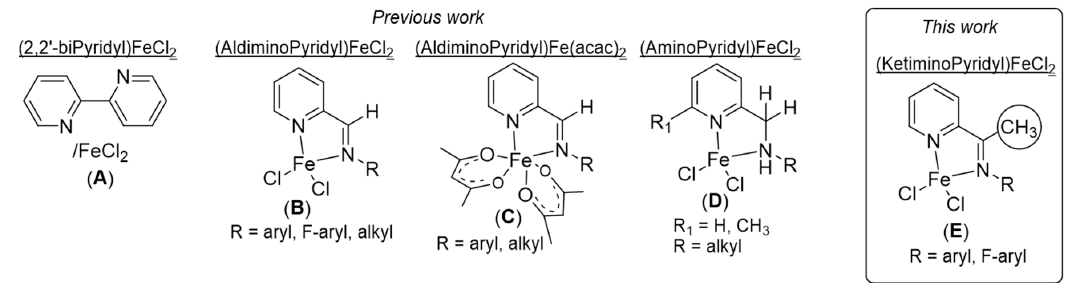
Figure 2. Iron-based complexes bearing bidentate pyridyl-based ligands for the polymerization of isoprene. (A). Ref [22]; (B). Ref [24–26]; (C). Ref [27], (D). Ref